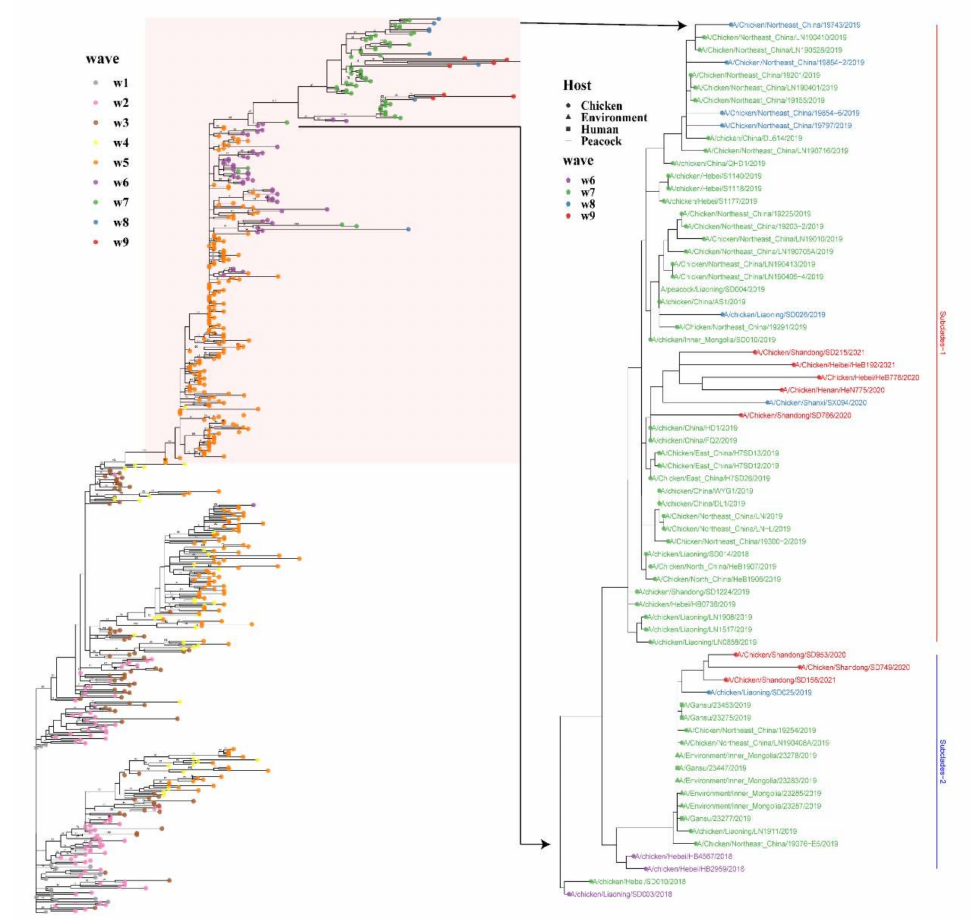
Figure 2. Maximum likelihood (ML) tree of H7N9 AIV. The area highlighted in pink indicates the HP branch. The nodes are plotted based on the bootstrap values. The tips of the phylogenetic tree are colored based on the outbreak waves (periods). The tree on the right panel contains the viruses isolated since